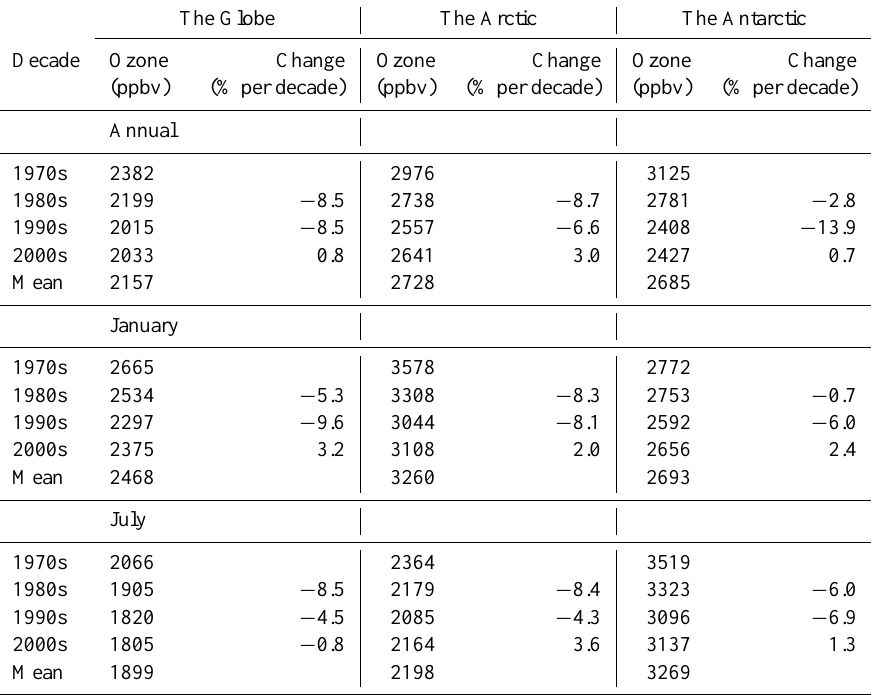
Table 4. Decadal variability of ozone mixing ratio at 19.5km averaged over the globe, the Arctic (60–90 ◦ N), and the Antarctic (60–90 ◦ S) from the 1970s to the 2000s in January and July. The mean is area-weighted and is computed by taking values only from grid cells where ozone data are available for all four decades. Therefore, the global means miss large areas in the tropics (see Fig. 12). The change is % per decade, and relative to the long-term mean. The Globe The Arctic The Antarctic Decade Ozone Change Ozone Change Ozone Change (ppbv) (% per decade) (ppbv) (% per decade) (ppbv) (% per